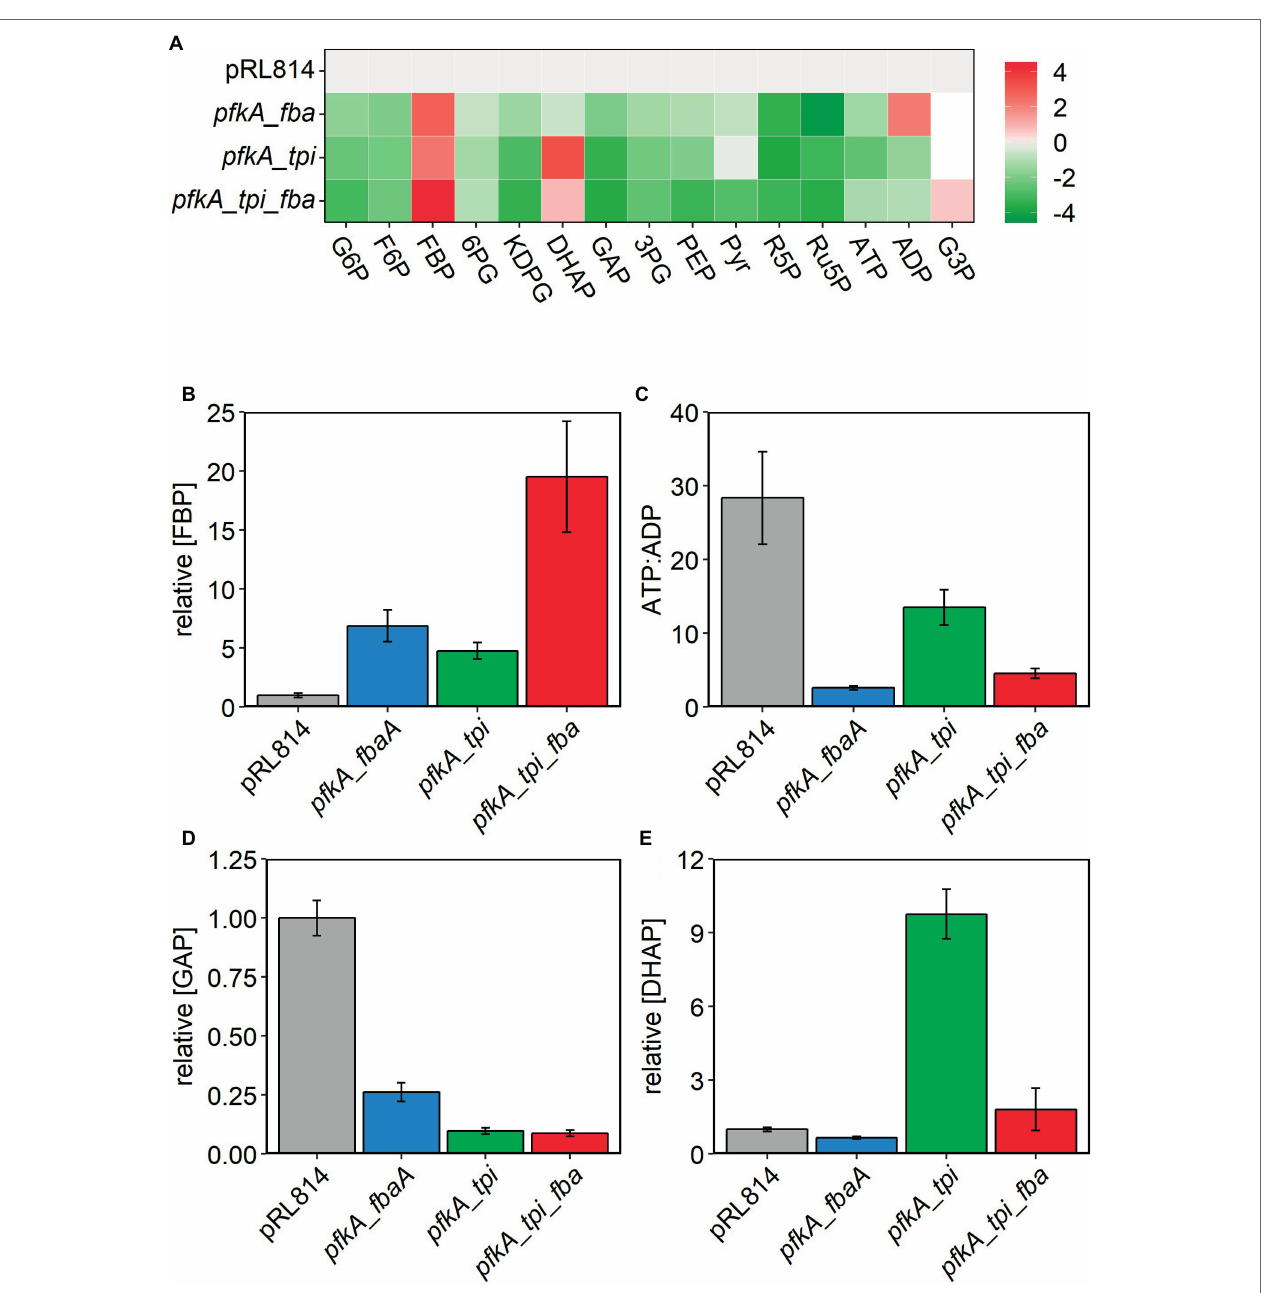
FIGURE 4 | Relative abundance of glycolytic metabolites observed by LC/MS in Z. mobilis with pRL814 or constructs expressing glycolytic enzymes from E. coli . Cells were grown in rich medium to OD 600 = 0.4–0.5 and metabolites were extracted and analyzed by LC/MS. Three biological replicates and two technical replicates were averaged for all strains except pfkA_tpi . Only one culture of pfkA_tpi showed characteristic slow growth at the time of harvest, and thus, only technical replicates of one culture were averaged. Data for the pfkA_tpi_fbaA strain are from a separate experiment, and signals were normalized to a pRL814 control for that experiment. Growth conditions were identical for both experiments. Only the experiment with pfkA_tpi_fbaA contains G3P observations. Six biological replicates were averaged for this strain. (A) Heatmap of intracellular metabolites shown as log 2 fold change relative to pRL814. (B–E) Relative concentrations of metabolites to pRL814 control. Concentrations of metabolites were calculated from LC/MS signals and response factors of metabolite standards. Abbreviations: 6PG, 6-phosphogluconate; 3PG, 3-phosphoglycerate; PEP, phosphoenolpyruvate; R5P, ribose-5-phosphate; Ru5P, ribulose-5-phosphate; G3P, glycerol-3-phosphate and those in Figure 1